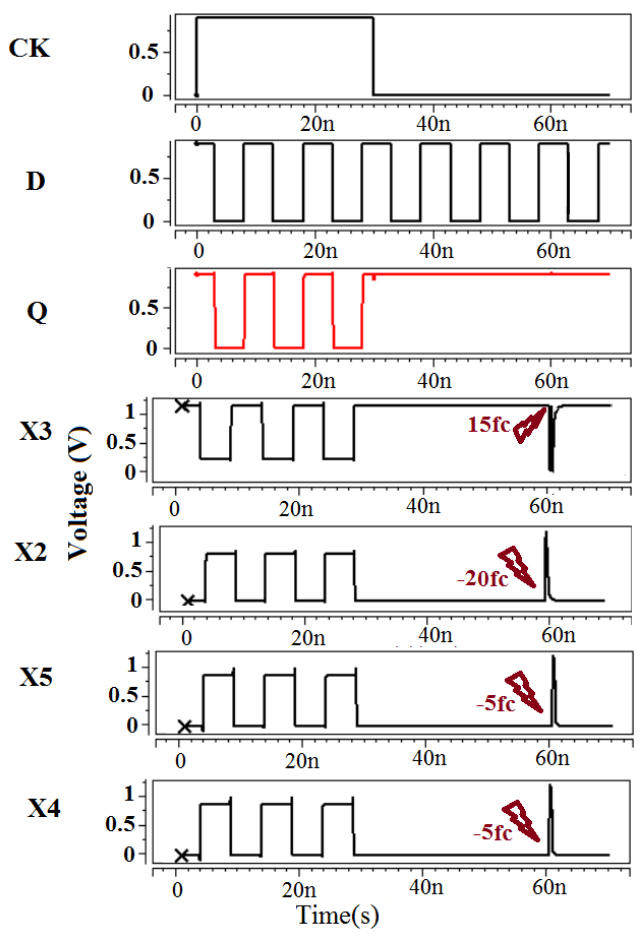
Figure 3. Test results for SEU injection to nodes when the output is “1” during the holding time; positive SEU injection to “X3” and negative SEU injection to “X2”, “X4”, and “X5” nodes.